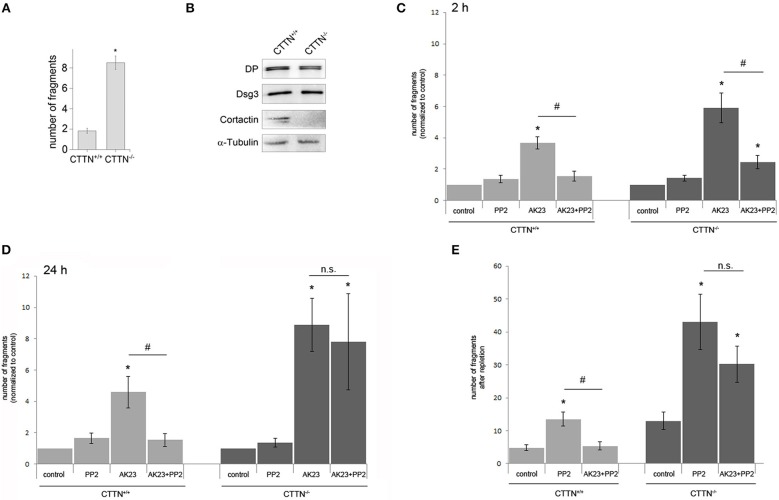
Role of cortactin in Src-mediated modulation of AK23-induced loss of cell cohesion. (A) Cortactin is important for cell cohesion, indicated by enhanced fragmentation of cortactin-deficient (CTTN−/−) cell monolayers in dispase-based dissociation assay (n = 5; *p < 0.05 vs. control). (B) Confirmation of cortactin knockout by Western blot, α-Tubulin served as loading control (n = 3). (C,D) CTTN−/− and wt mouse keratinocytes exposed to a dissociation assay following either short time (2 h) or long time (24 h) incubation with AK23 (n > 7, #p < 0.05; *p < 0.05 vs. control). (E) Reconstitution of cell adhesion measured by dissociation assay after Ca2+ switch in CTTN−/− and wt keratinocytes in absence or presence of Src inhibitor PP2 (n > 7, #p < 0.05; *p < 0.05 vs. control).